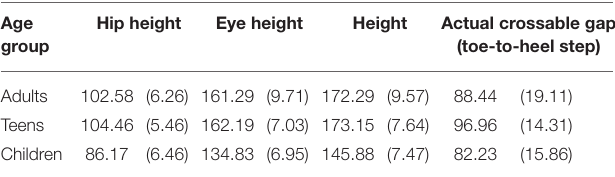
TABLE 1 | Means (SD) of body dimensions and actual crossable gap in cm for Experiment 1.